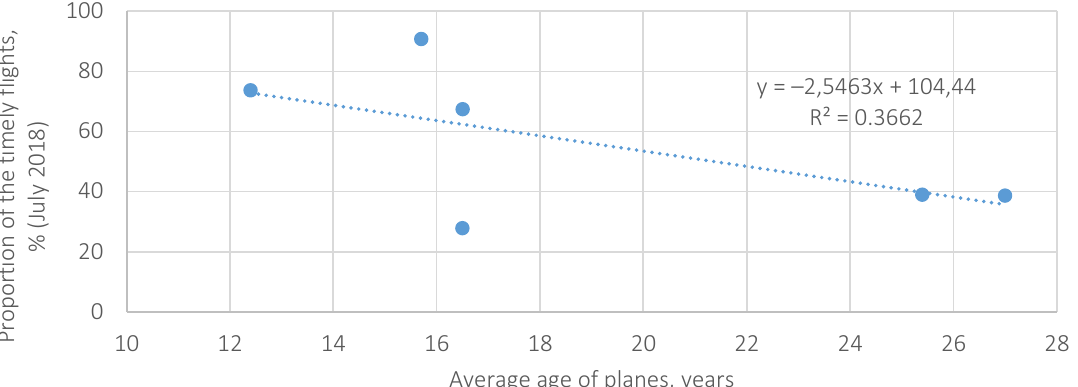
Figure 5. Linear trend for the proportion of timely flights by Ukrainian airlines depending on the average age of the